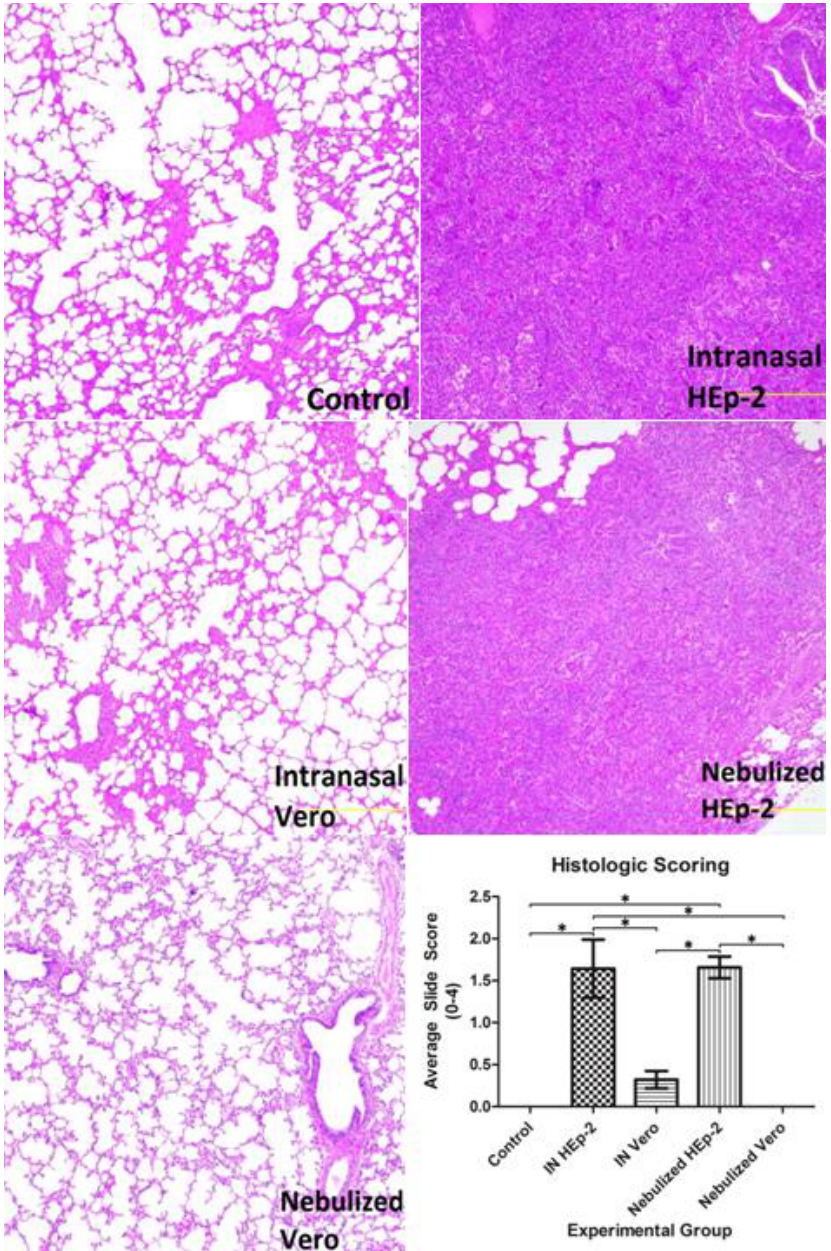
Figure 4. Histopathologic findings of selected lung lesions from each group. Lung from a control lamb with normal histologic appearance (Control). Lung from a lamb with intranasal inoculation of HEp-2-grown virus (INH) with dense consolidation around neutrophilic bronchiolitis (Intranasal HEp-2). Lung from a lamb with intranasal inoculation of Vero-grown virus (INV) with slight thickening of bronchiolar adventitia and minimal alveolar septal thickening both caused by infiltrate of lymphocytes and macrophages (Intranasal Vero). Lung from a lamb with nebulized RSV grown in HEp-2 (NeH) with a consolidation pattern similar to INH, although fewer areas are consolidated (Nebulized HEp-2). Lung from a lamb with nebulized RSV grown in Vero cells (NeV) that lacks lesions (Nebulized Vero). The INH group had a significantly higher score (see methods for scoring criteria) than control, INV and NeV groups, while NeH had a significantly higher score than control, INV, or NeV groups, p <